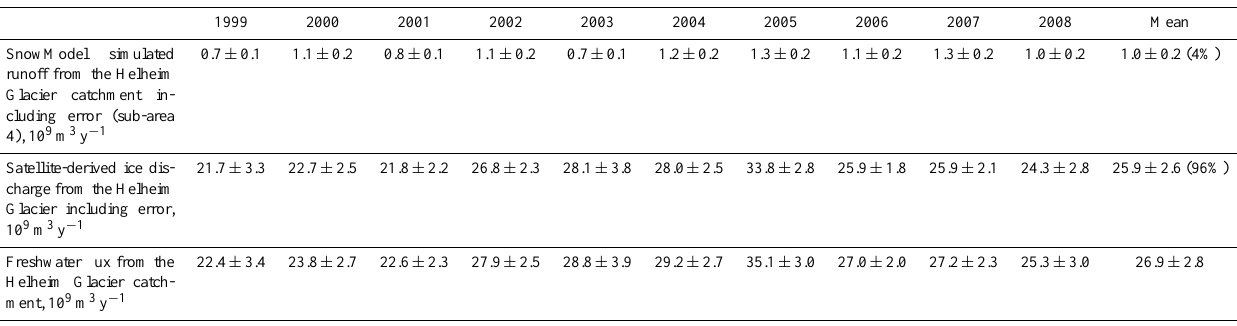
Table 2. Freshwater flux from the Helheim Glacier catchment based on SnowModel simulated freshwater runoff and satellite-derived ice discharge.